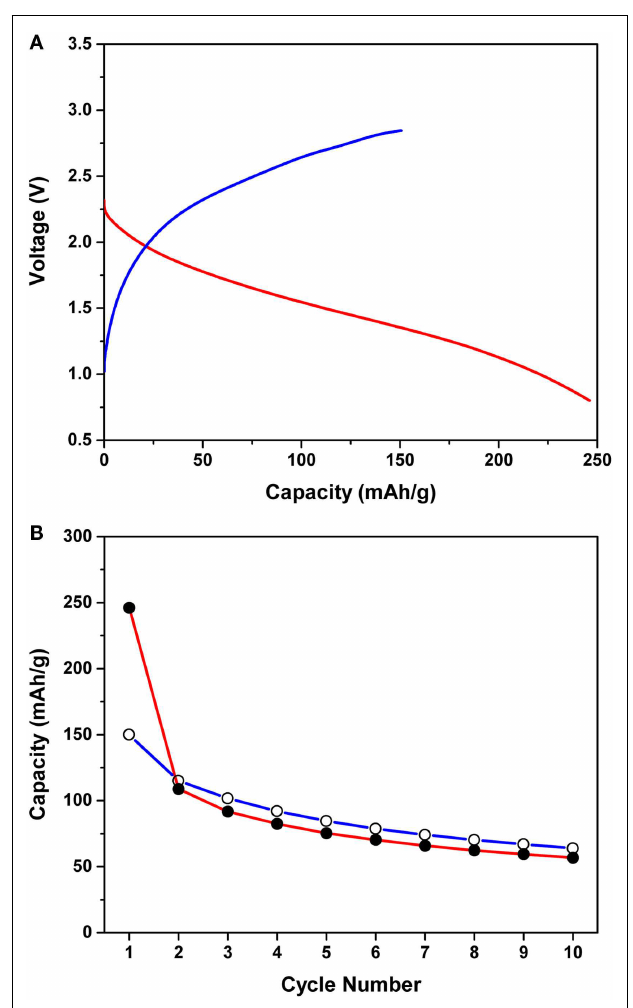
FIGURE 1 | (A) First magnesiation/de-magnesiation curves of the Mg/MnO 2 cell with the APC electrolyte, at an applied current density of 0.1mA/cm 2 at 25°C.The cut-off conditions were 0.8 and 2.85V during magnesiation and de-magnesiation, respectively. (B) Cycling performance of the Mg/MnO 2 cell with the APC electrolyte for the first 10 cycles. Shaded and unshaded circles denote the magnesiation and de-magnesiation capacities, respectively.